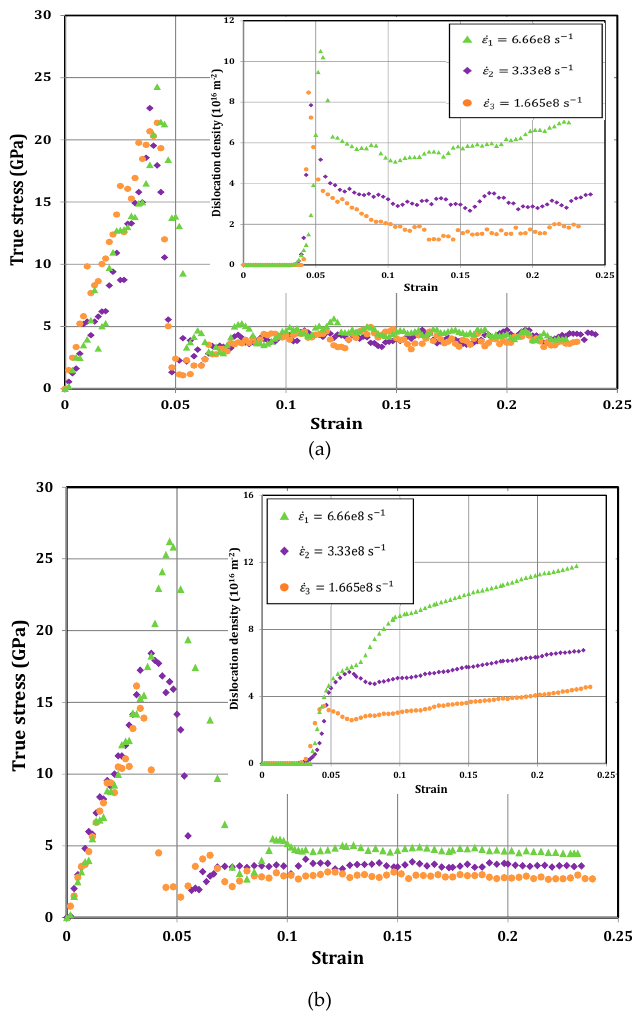
Figure 22. The responses of the samples during micropillar compression test with different strain rates of . ε = 6.66 × 10 8 s − 1 , . ε = 3.33 × 10 8 s − 1 , and . ε = 1.665 × 10 8 s − 1 in the cases of pillars with the diameters of : ( a ) D = 45 nm; ( b ) D = 150 nm (after Voyiadjis and Yaghoobi [16]).